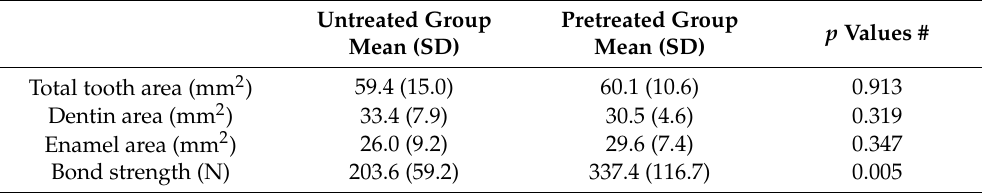
Table 1. The total tooth area, enamel and dentin area and bond strength–comparisons between the untreated group (n = 10) and pretreated group (n = 10) specimens.